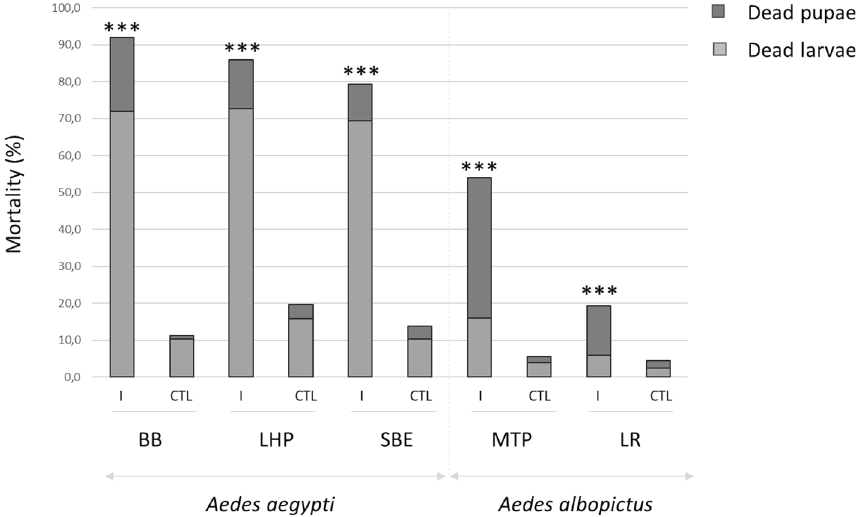
Figure 1. Percentage of cumulative mortality, corresponding to dead larvae or pupae, 25 days following AalDV2 infection of first instar mosquito larvae from different strains of Ae. albopictus (MTP, Montpellier and LR, La Réunion) and Ae. aegypti (LHP, Long-Hoà, BB, Bora-Bora and SBE, Benin). Larvae (N = 3 replicates of 150 larvae per experimental condition) were infected, or not, with 3 × 10 11 veg/ml of AalDV2. Binomial linear mixed effect models were used to compared the impact of AalDV2 in infected groups (I) compared to control groups (CTL). ***p-value < 0.001.